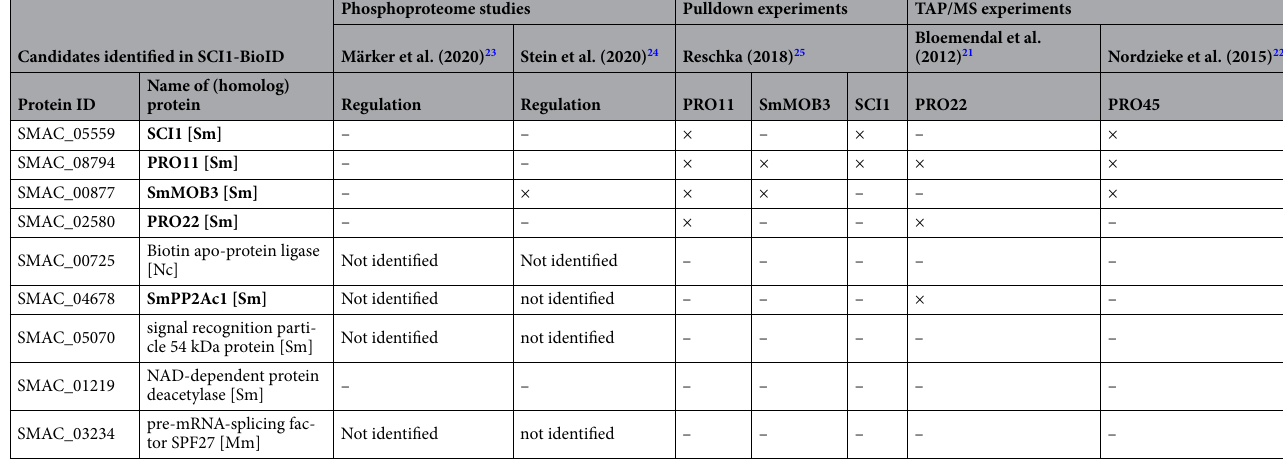
Table 3. Comparison of SCI1-BioID candidates with previous studies investigating SmSTRIPAK interactors. Significantly enriched proteins of the SCI1-BioID experiment (enrichment factor ≥ 4) were compared to